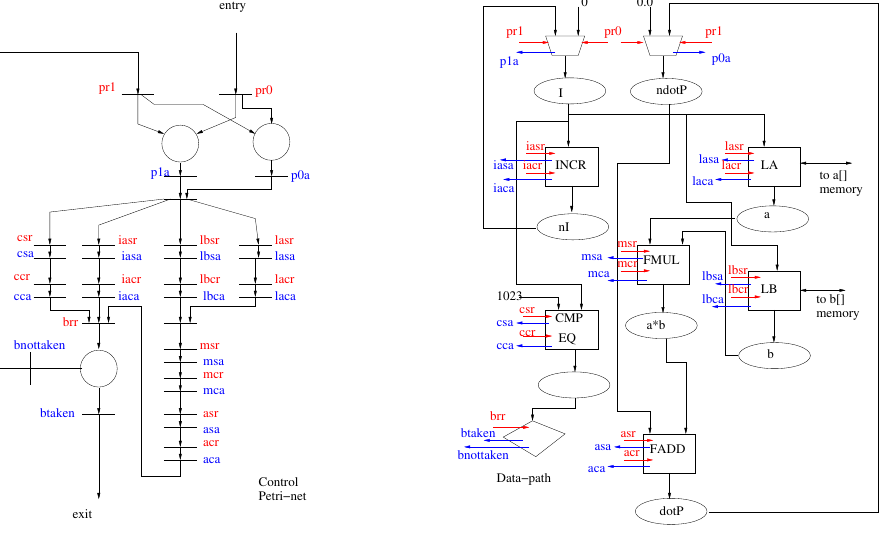
Figure 3. Control data storage virtual circuit